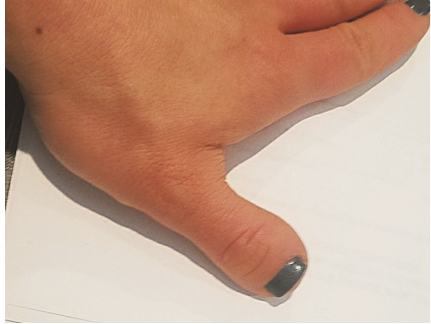
Figure 3: Short and broad thumb of the